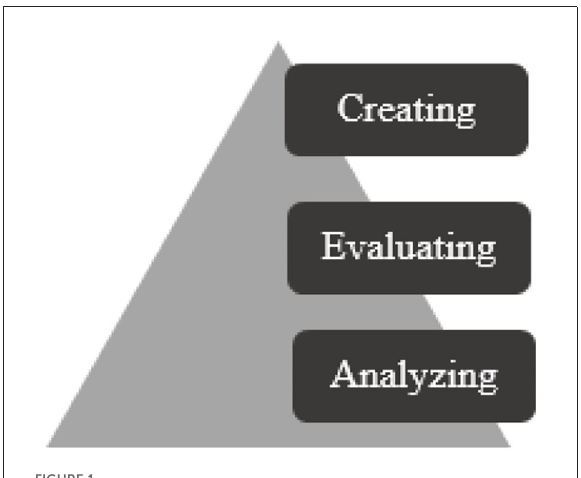
FIGURE1 HOTS in Bloom’s taxonomy (conceptualized by the researchers).